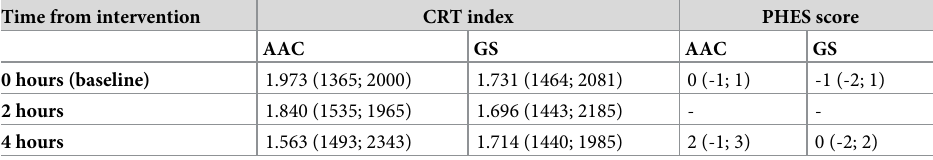
Table 4. Continuous Reaction Time (CRT) Index and the Psychometric Hepatic Encephalopathy Score (PHES) according to randomization and time of examination from intervention. Median (25% quantile; 75% quantile) n =